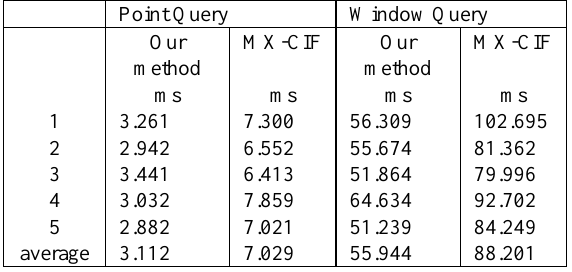
Table 2. Query Time with Our Index Comparing to CIF Quadtree